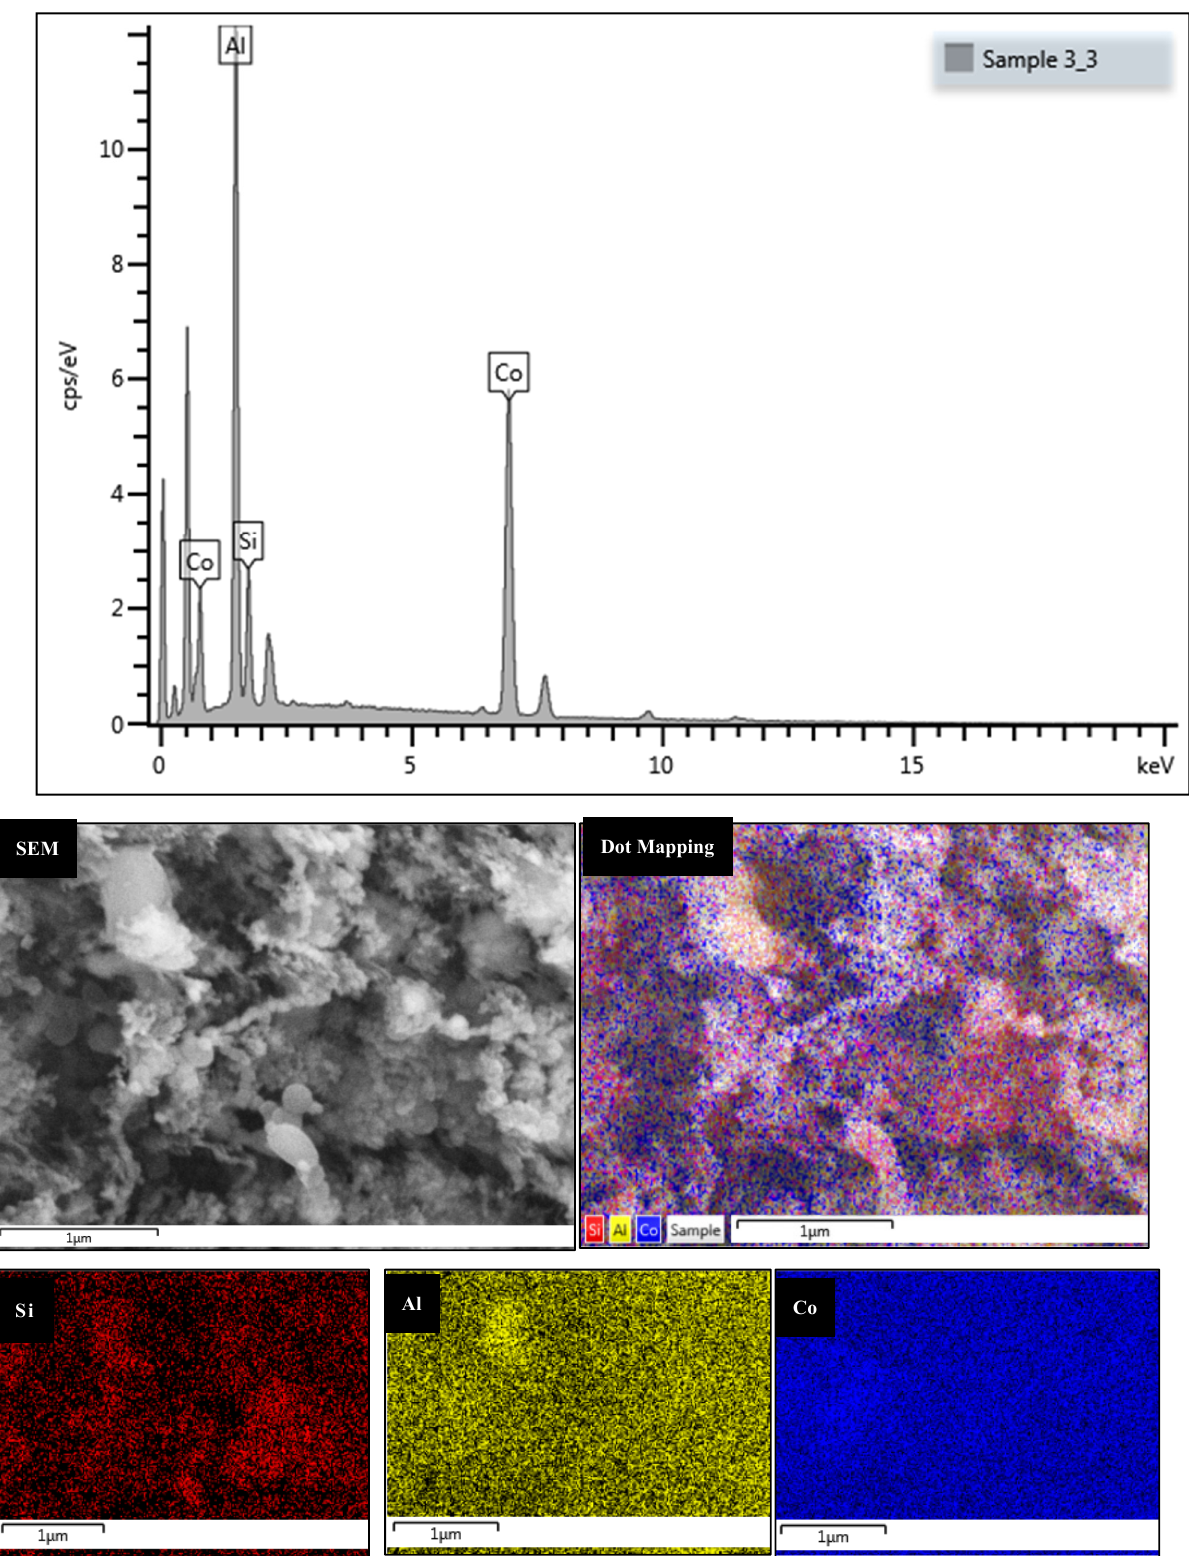
Figure 20. EDX dot mapping analysis of the surface of a used 6 wt% Co catalyst.